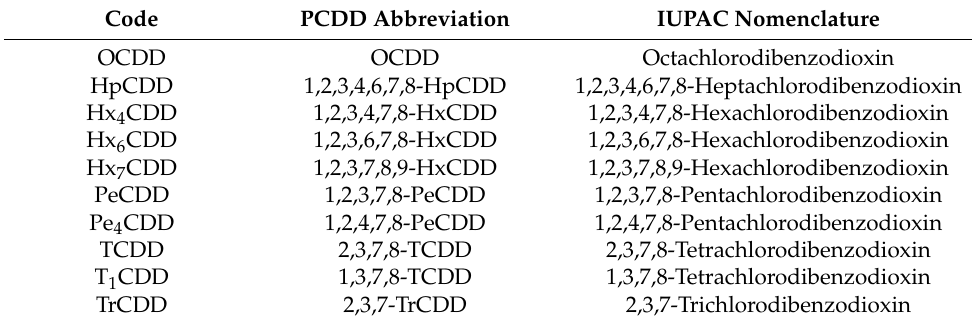
Table 1. Description of the codes used for the PCDD series of this study. Code